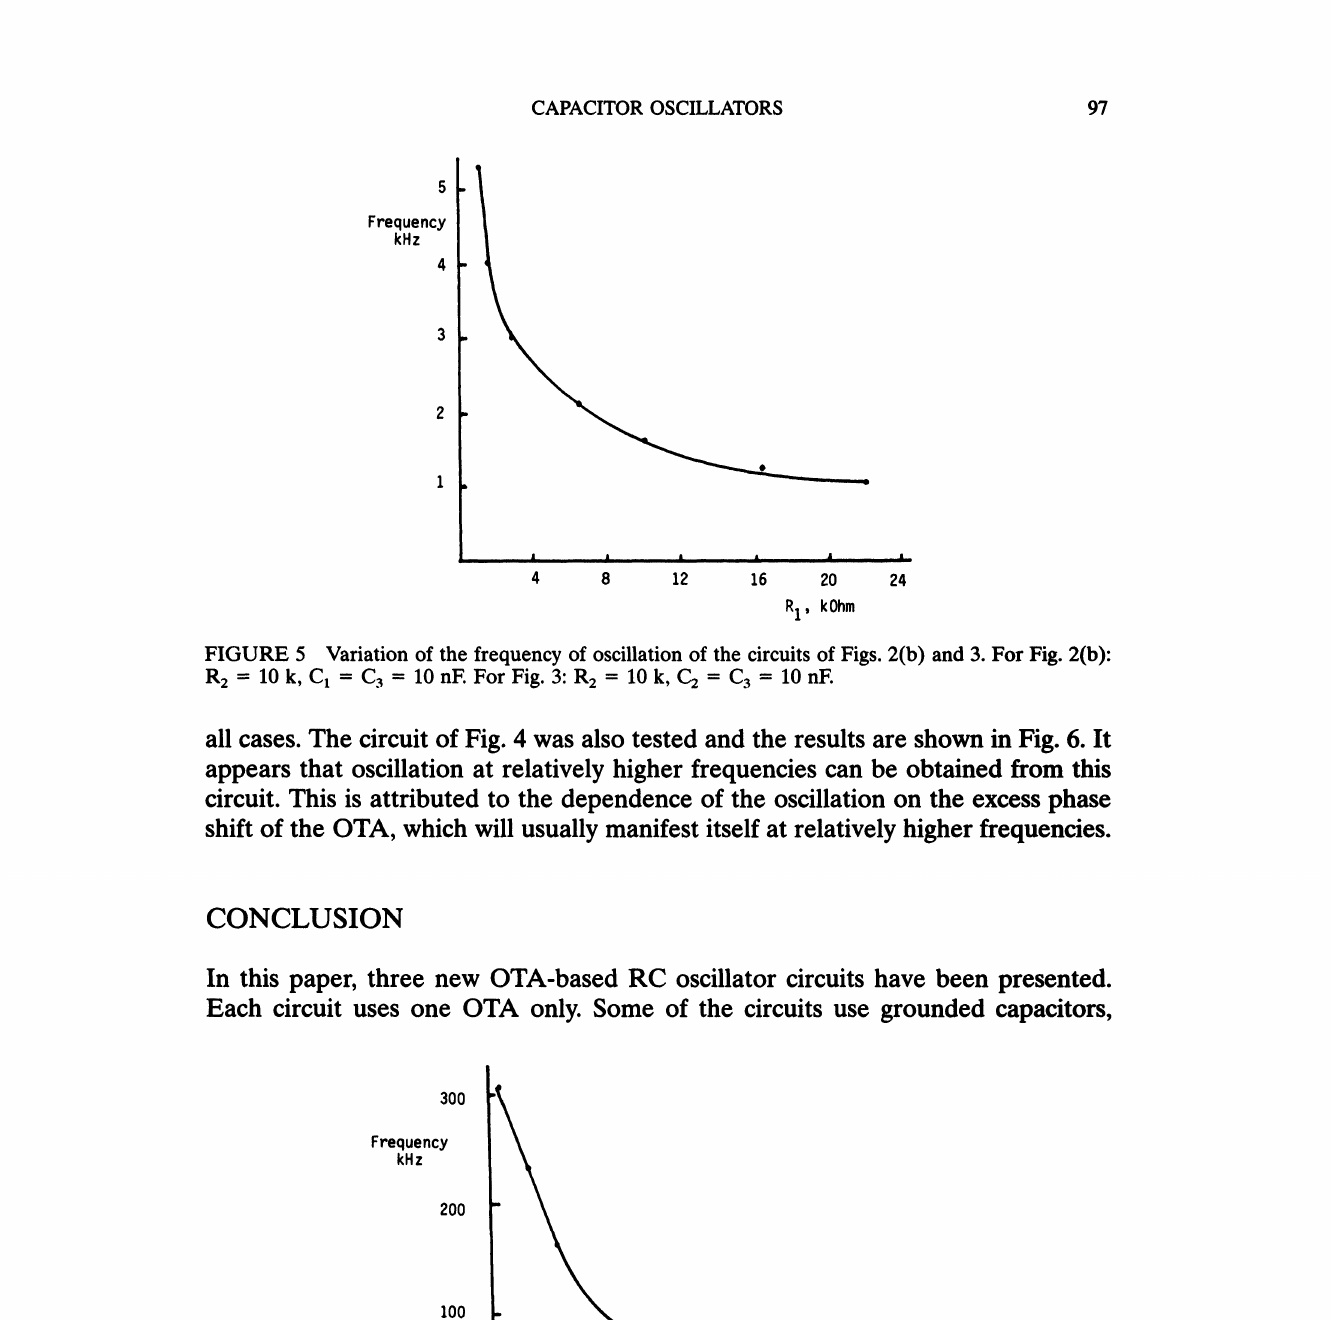
FIGURE 6 Variation of the frequency of oscillation of the circuit of Fig. 4. Ca 220 pF, R